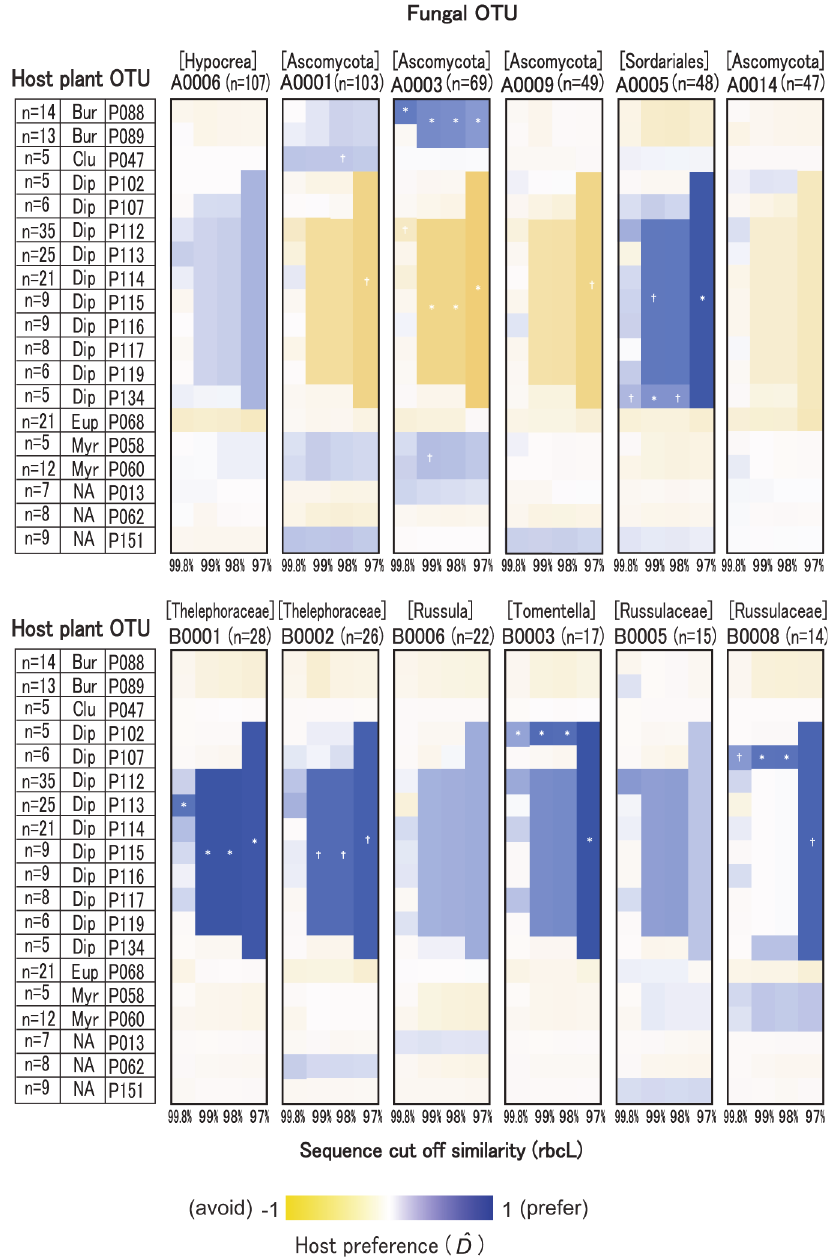
Fig 2. Posterior distribution of D ^ values (expected degrees of apparent host preference) for representative root-associated fungal OTUs detected in the root samples. D ^ values are shown separately for the datasets of respective cut-off similarities of host plant sequences. Host plant OTUs represented in (cid:5) 5 samples are shown. Color gradients indicate D ^ value of each fungal OTU. Plant OTU families are abbreviated as Bur (Burseraceae), Clu (Clusiaceae), Dip (Dipterocarpaceae), Eup (Euphorbiaceae), Myr (Myrtaceae), and NA (family information was not available). An asterisk and a dagger indicate a 99% and 95% credible interval that does not contain 0,